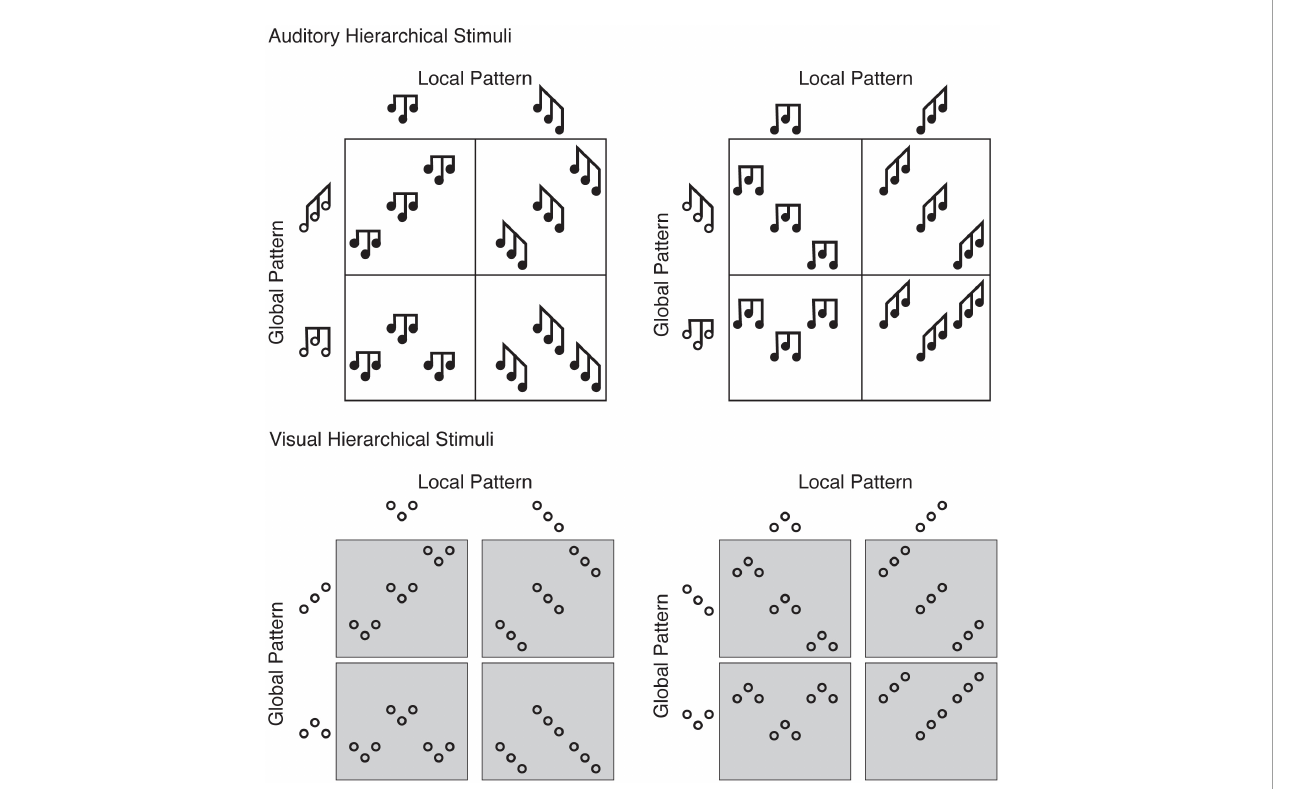
FIGURE1 The 16 hierarchical stimuli, created by the factorial combination of rising-rising and rising-falling patterns, with falling-rising and falling-falling patterns, and hierarchical level (global and local). For each participant, because their response mapping was counter-balanced, one participant’s target pattern (e.g., a rising-rising global pattern is a target for those with rising-rising and rising-falling assignments) was a distracter pattern for another participant (the same rising-rising global pattern is a distracter for those with falling-rising and falling-falling assignments, which would be presented locally). (Top) For the auditory hierarchical stimuli, the black notes depict individual tones, where the horizontal axis shows time (the leftmost occurs first and proceeds left to right) and the vertical axis shows frequency (the lowest corresponds to F# 3 and highest to A# 4 ). Each local pattern is a three-tone sequence repeated three times to produce a nine-tone global pattern. If a participant were assigned a response mapping of falling-rising and falling-falling patterns, they should respond “falling-rising” when the two leftmost stimuli are presented (falling-rising pattern presented at the local level) as well as when the two bottom right stimuli are presented (falling-rising pattern presented at the global level). (Bottom) For the visual hierarchical stimuli, “rising” refers to a southwest-to-northeast left-to-right relationship between neighboring circles, and “falling” refers to a northwest-to-southeast left-to-right relationship between neighboring circles. As with the auditory stimuli, if a participant were assigned a response mapping of falling-rising and falling-falling patterns, they should respond “falling-rising” when the two leftmost stimuli are presented (falling-rising pattern presented at the local level) as well as when the two bottom right stimuli are presented (falling-rising pattern presented at the global level). For those more familiar with visual hierarchical letter stimuli, the analogy is presenting the letters A and E at one level, and S and H at another level. Participants respond to, for example, A and S as target patterns, whether presented at the local or global